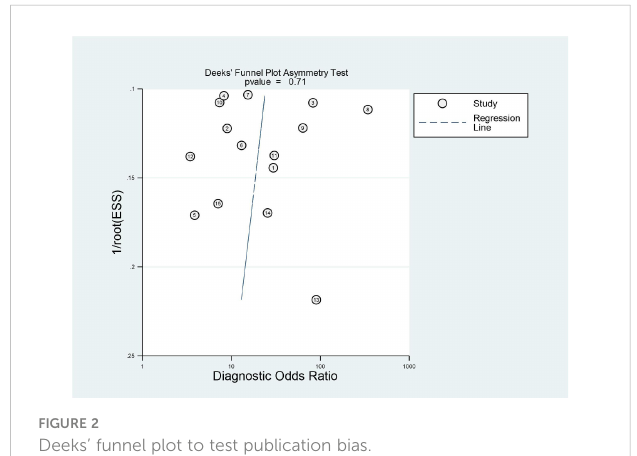
FIGURE 2 Deeks ’ funnel plot to test publication